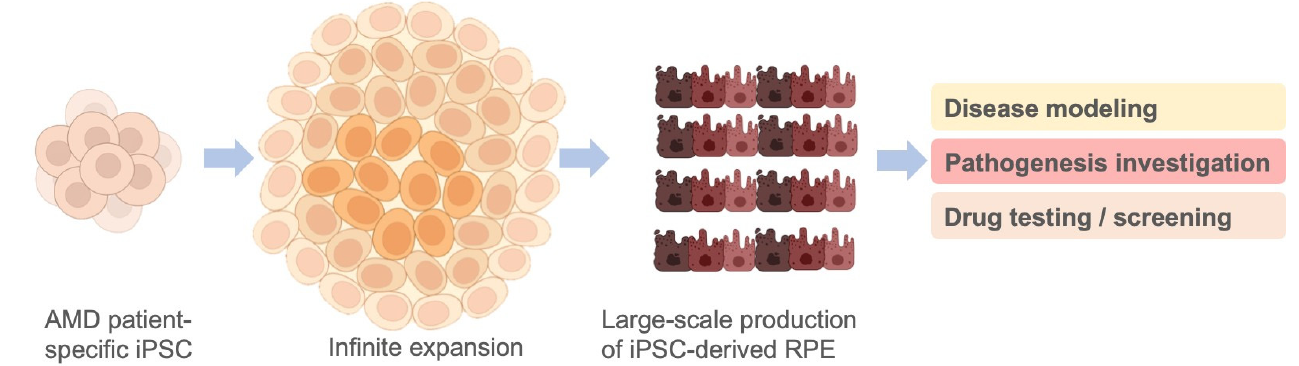
Figure 5. Potential of patient-specific iPSC-derived RPEs for large-scale production. Patient-derived iPSCs can be easily obtained from patients’ somatic cells and expanded infinitely in culture, allow- ing the large-scale production of iPSC-derived RPEs to meet the demand of disease modeling, path- ogenic mechanism investigation, and drug testing/screening. (Image credit—Created with BioRen-